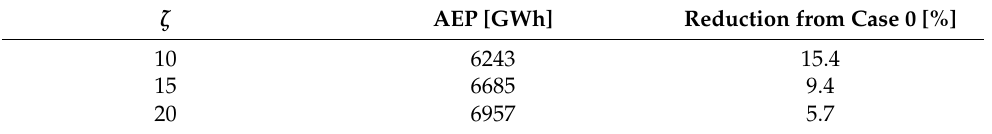
Table 4. AEP values for Case